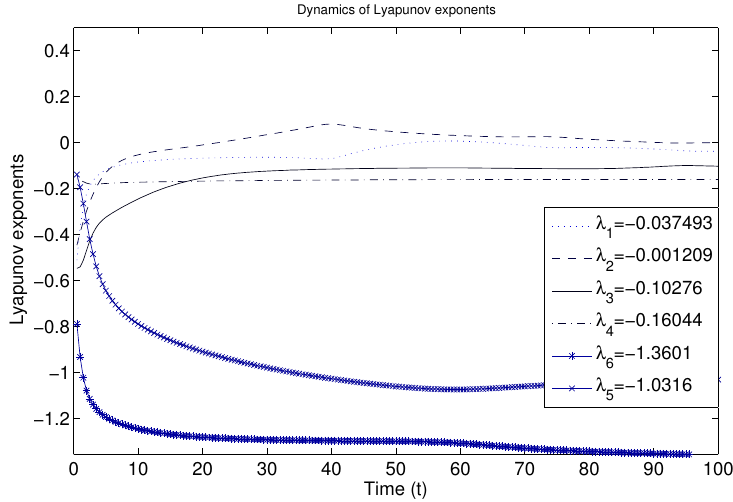
Figure 10. Other parameters are as in the